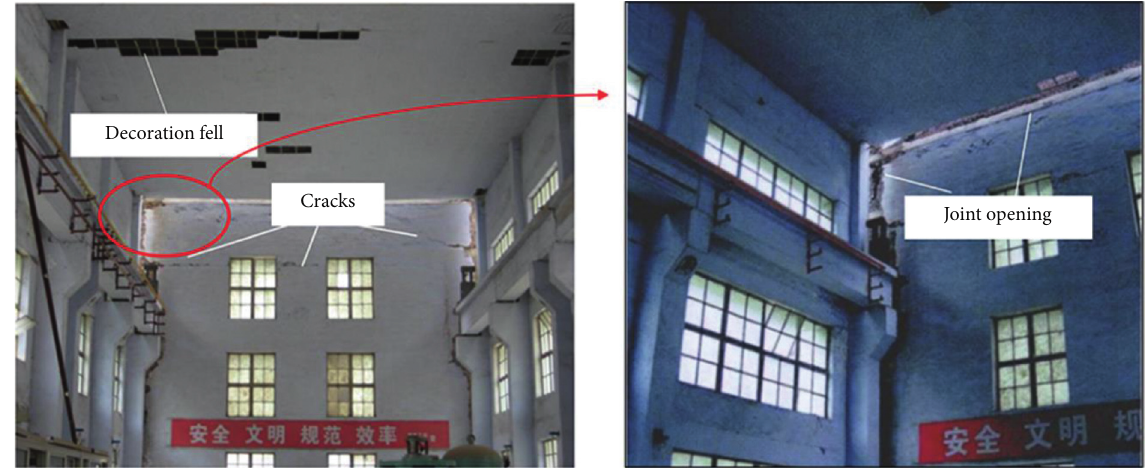
Figure 2: Damage caused by Wenchuan earthquake in CaoPo